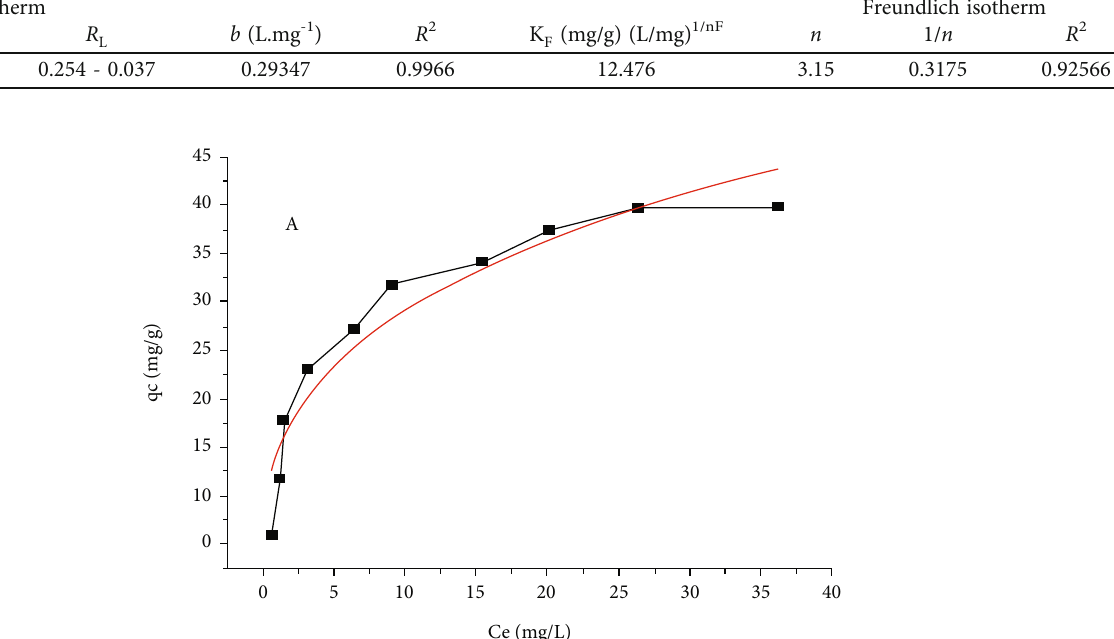
Table 13: The Langmuir and Freundlich adsorption isotherms. Langmuir isotherm Freundlich